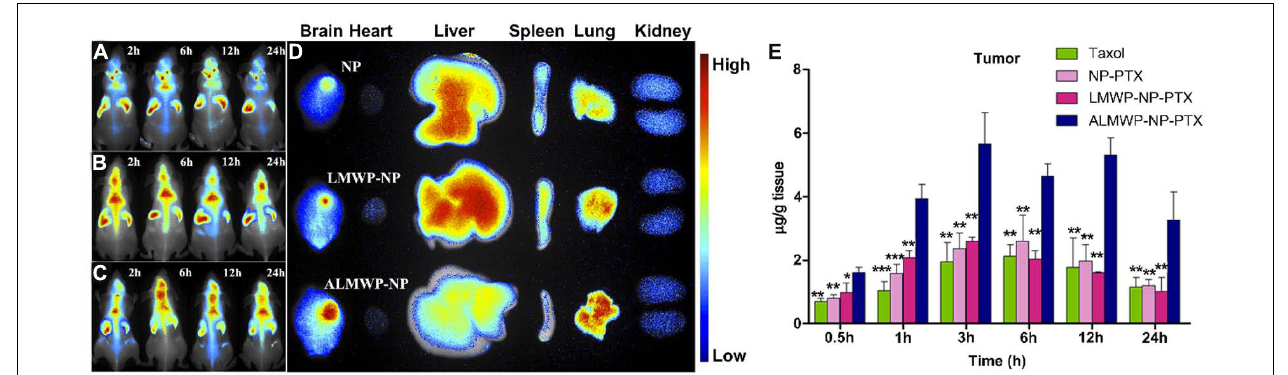
after intravenous injection of the various micelle particles. (E) Accumulation of intravenously injected compounds at the tumor site from 0.5 to 24 h after administration. * p < 0.05, ** p < 0.01, *** p < 0.001 was indicative of significant difference between the experimental and ALMWP-NP-PTX group. Error bars reflect the standard deviation. Reproduced with permission from Gu etal.